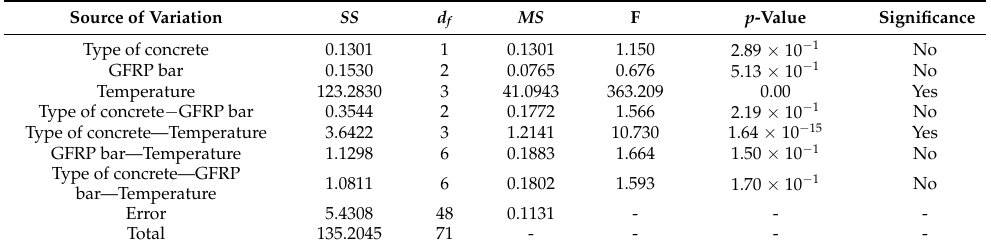
Table 8. ANOVA analysis results for GFRP-Y samples tested at 23 ◦ C–350 ◦ C.